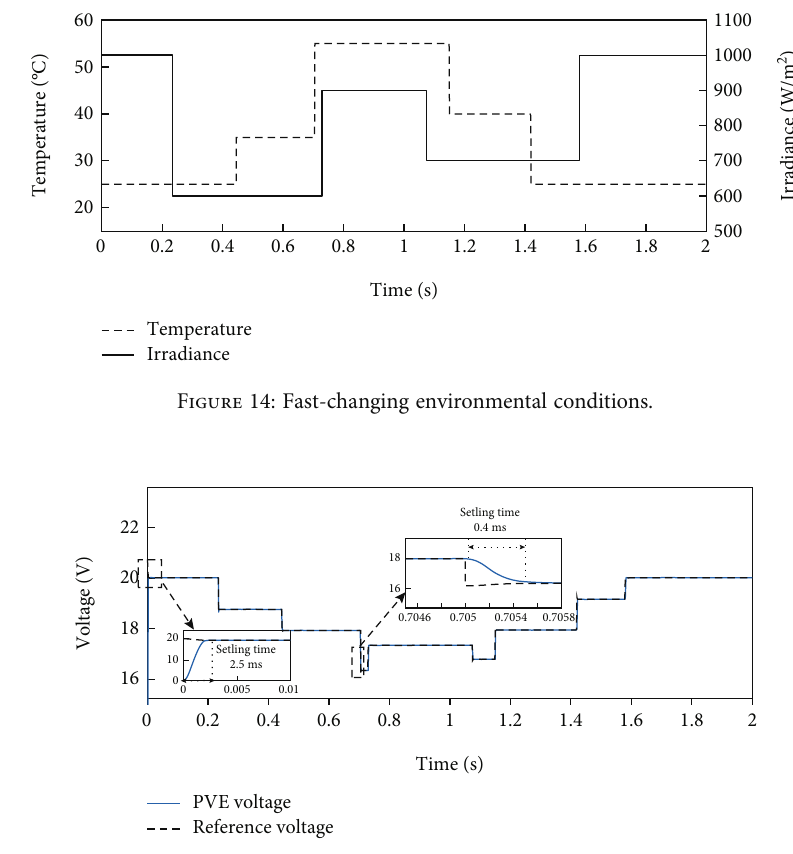
Figure 15: Response of the PVE to fast-changing irradiance (voltage).